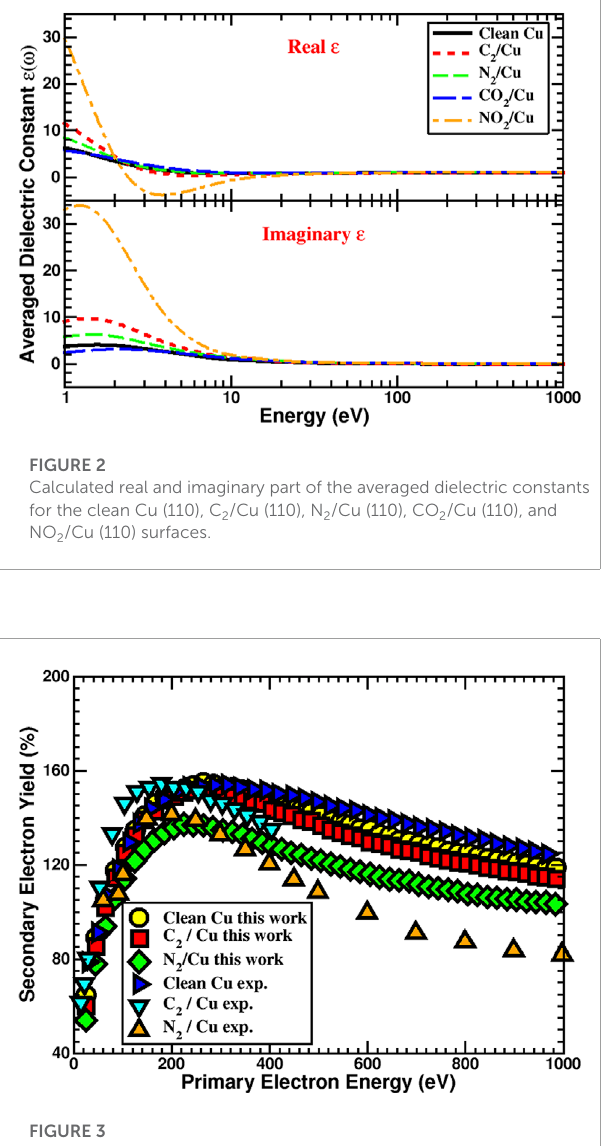
excess electrons created due to C secondary electrons generated in the Cu back into the system. This repulsive interaction reduces the probability of electrons escaping from the surface. Therefore, because of the higher charge transfer and the creation of an electronic barrier, the SEY for the N system is reduced significantly with respect to the C and clean Cu